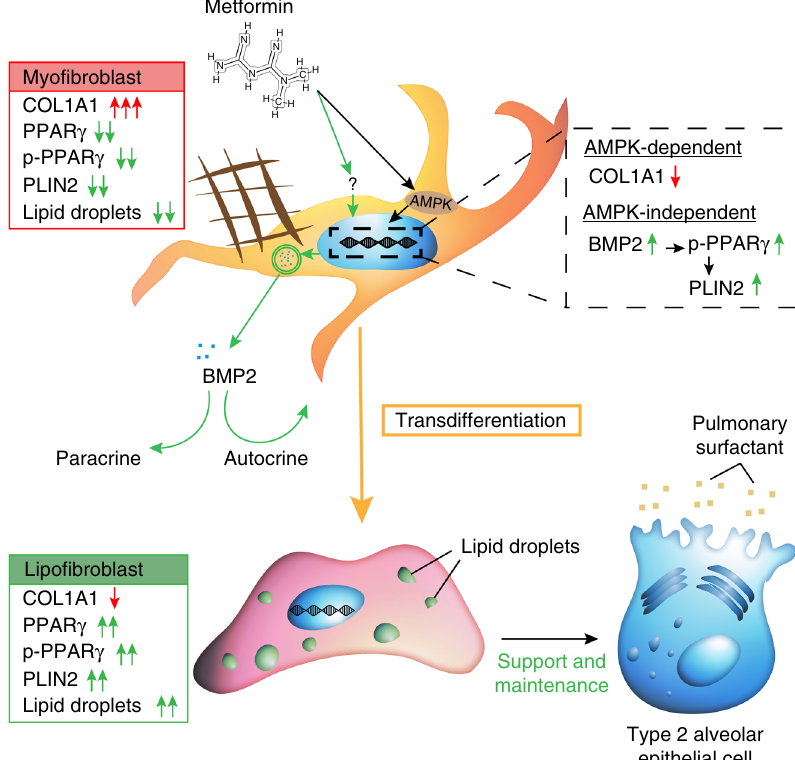
Fig. 8 Model for the anti fi brotic mechanism of action of metformin in human lung fi brosis. Metformin activates AMPK signaling in myo fi broblasts, leading to suppression of collagen production, and induces lipogenic differentiation via an AMPK-independent mechanism involving BMP2 release and PPAR γ phosphorylation. Arising lipo fi broblasts are known to support type 2 alveolar epithelial stem cells in the lung